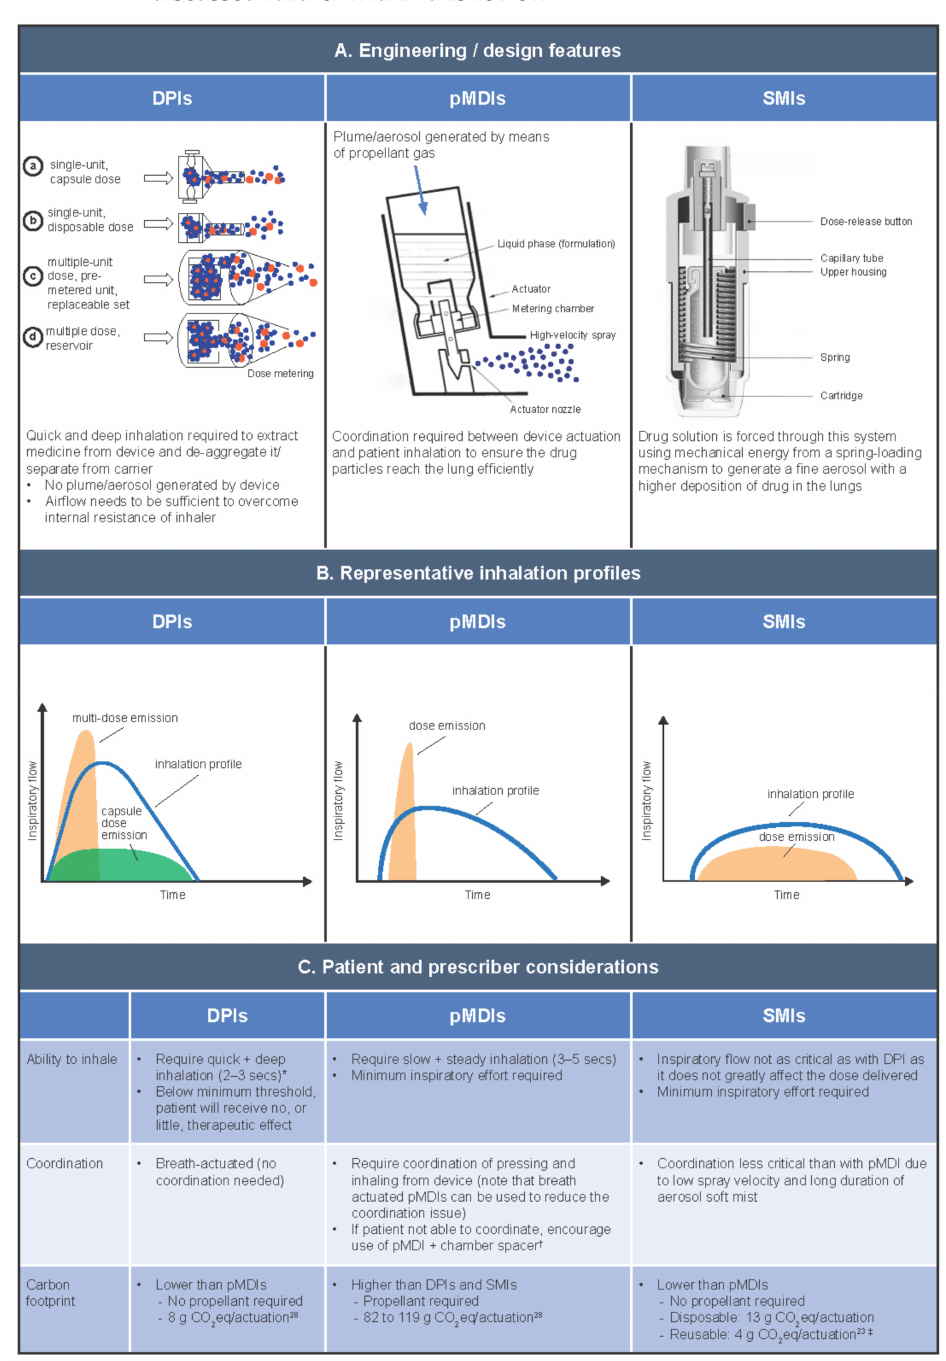
Figure 3. Design features, inhalation profiles, and patient considerations for the three main classes of inhalation device. * For low resistance DPIs, slow and deep inhalation is required; † Consider relevant national guidelines/best practice; ‡ The disposable device provides one month’s usage (60 actuations); the reusable device, which has replaceable cartridges, provides six months’ usage (360 actuations). DPI, dry powder inhaler; pMDI, pressurized metered-dose inhaler; SMI, soft mist inhaler.